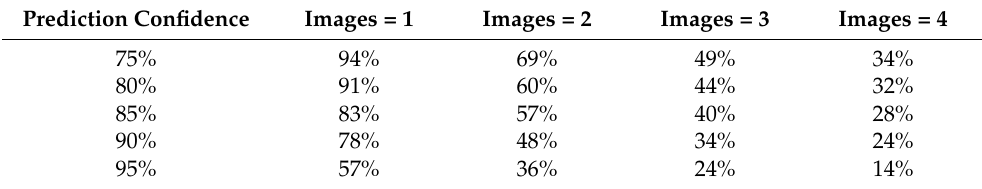
Table 2. False positive percentages when testing the system on 100 non-defective gear scans. “Images = X” represents the number of sequential images of the gear scan where a defect was pre- dicted with a probably greater than the corresponding prediction confidence. Prediction Confidence Images = 1 Images = 2 Images =